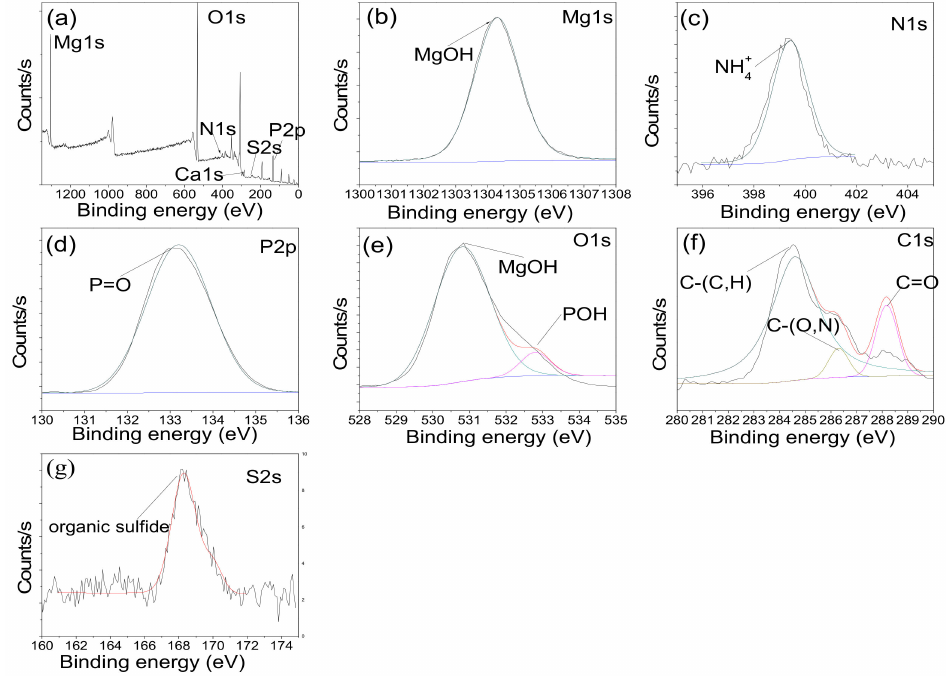
Figure 9. XPS spectra of struvite induced by the bacterium ZW123 (( a ): bond survey of biotic struvite surface; ( b – g ): high-resolution of Mg, N, P, O, C and S,